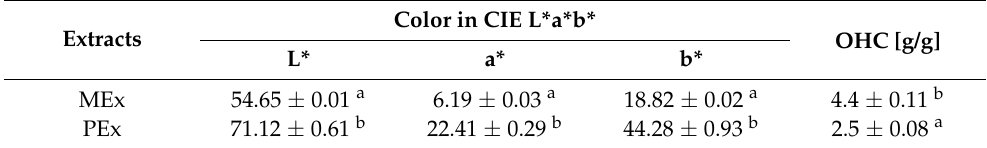
Table 2. Mean ± SD for color coordinates in CIE L*a*b* and oil holding capacity (OHC) of MEx and